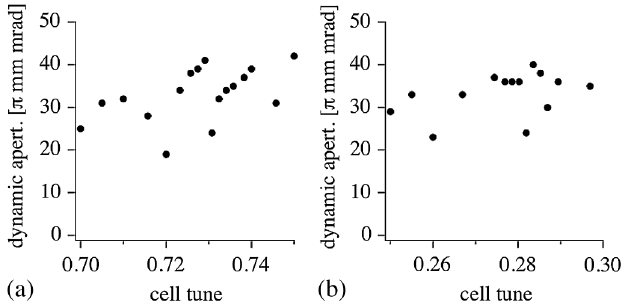
FIG. 10. Difference in field gradient between Taylor expanded scaling field and exact scaling field.